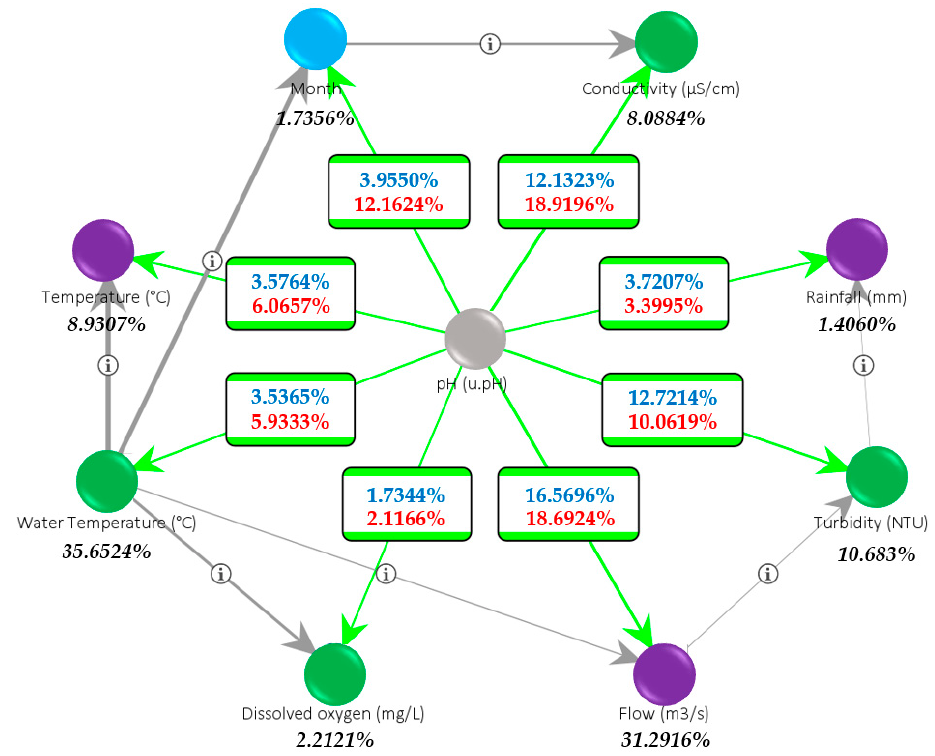
Figure 4. Supervised BN built with Augmented Naïve Bayes algorithm. The graph presents a radial layout with the target node (pH) in the center. The color of the nodes represents the type of variable: chemical, physical, or temporal. The values of the arcs correspond to the RMI (%) analyses, and the values of the nodes are the variable contributions to the target node (%).